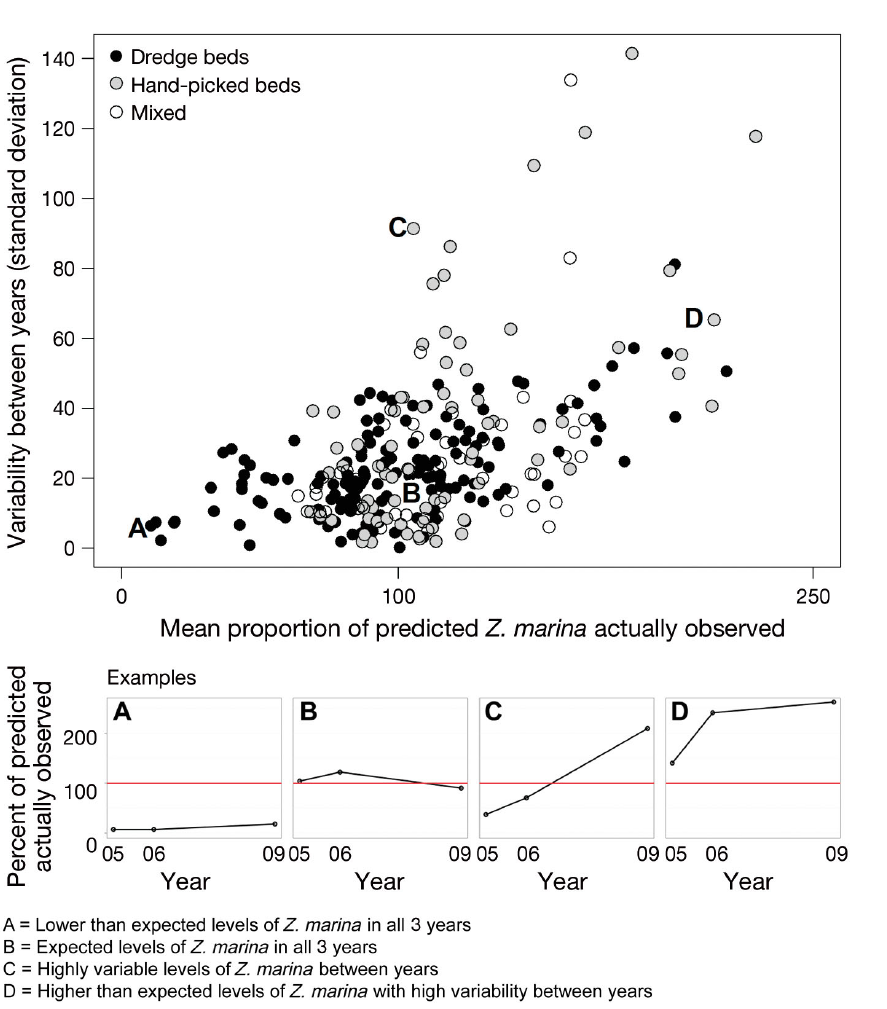
Fig. 5. Relationship between the variability in Zostera marina present between years and the proportion of predicted Z. marina present for individual beds (top). When examined over time, individual beds exhibited 4 general patterns: (A) beds with chron- ically low Z. marina and low variation across years, (B) beds with the expected levels of Z. marina with low variation across years, (C) beds with highly variable levels of Z. marina across years, and (D) beds with high levels of Z. marina with high vari- ation across years (lines represent trends in average predicted Z. marina /actual Z. marina , with red lines indicating 100%). Most beds cluster around B, with the expected amount of Z. marina cover remaining stable across years. All of the beds with lower than expected Z. marina present were mechanically harvest beds ( x = 65%, n =